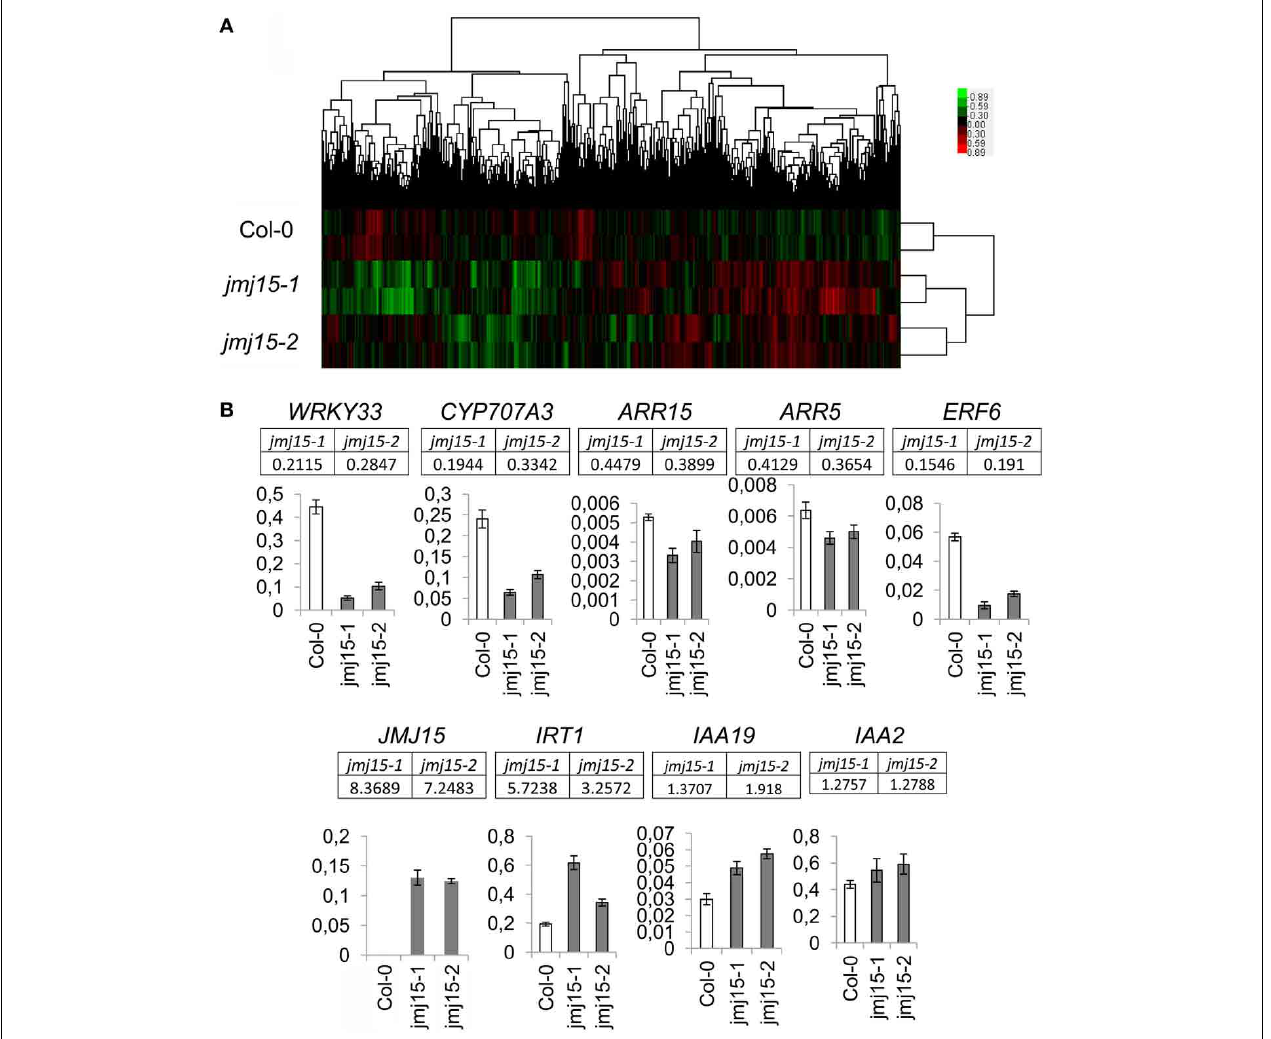
FIGURE 5 | Transcriptomic analysis of jmj15-1 and jmj15-2 (12 day-old) seedlings compared to wild type grown in ½MS medium. (A) Pair-wise plots of the microarray hybridization signals between the biological replicates of each sample and the between wild type and two 2 mutant alleles. Green: